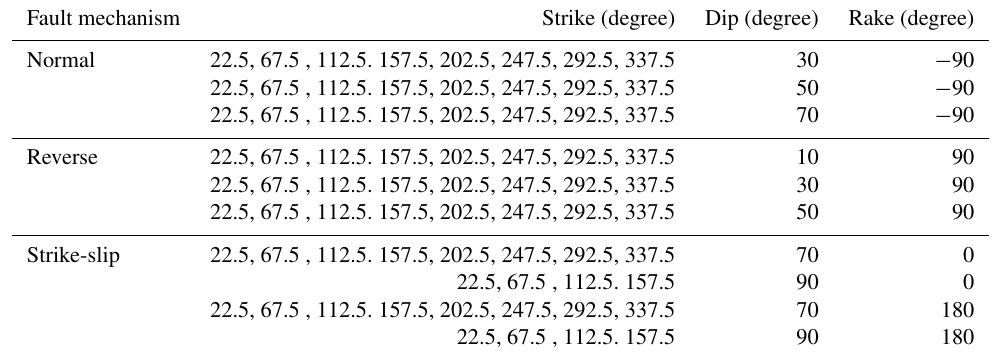
Table 1. Focal mechanisms and depths of the top of the faults considered testing the performances of the database in the Mediterranean Sea. Fault mechanism Strike (degree) Dip (degree) Rake (degree)